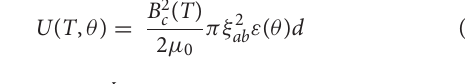
FIGURE 11 | Variation of J c and F p with applied magnetic field for YBCO:YBNTO (YBCO frequencies, at 77K (A,C) and 30K (B,D) . Reproduced from Opherden et al.